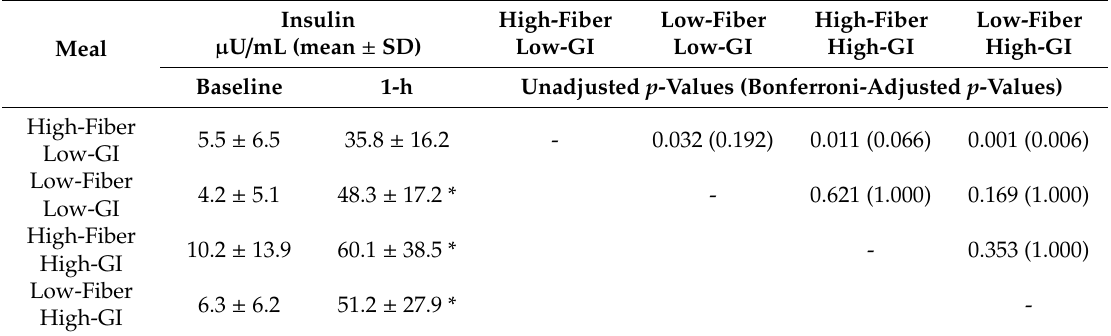
Figure 4. Insulin responses to four meals di ff ering in glycemic index (GI) and dietary fiber content. Dashed lines represent individual subject responses. Solid lines represent mean responses for all subjects. See text and Table 4 for statistical comparisons between meals. Table 4. Plasma insulin responses 1-h postprandial: Comparisons between meals.